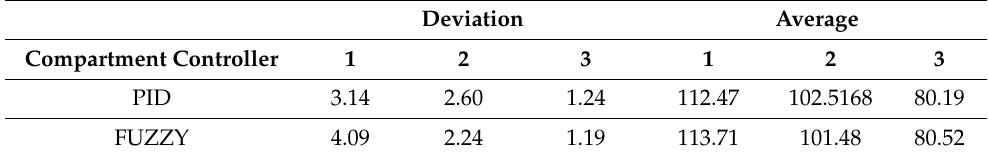
Figure 10. Waveform of changes in the position of the distribution layer in compartment 3 when using the fuzzy controller. Table 3. Mean values and standard deviations of recorded waveforms.